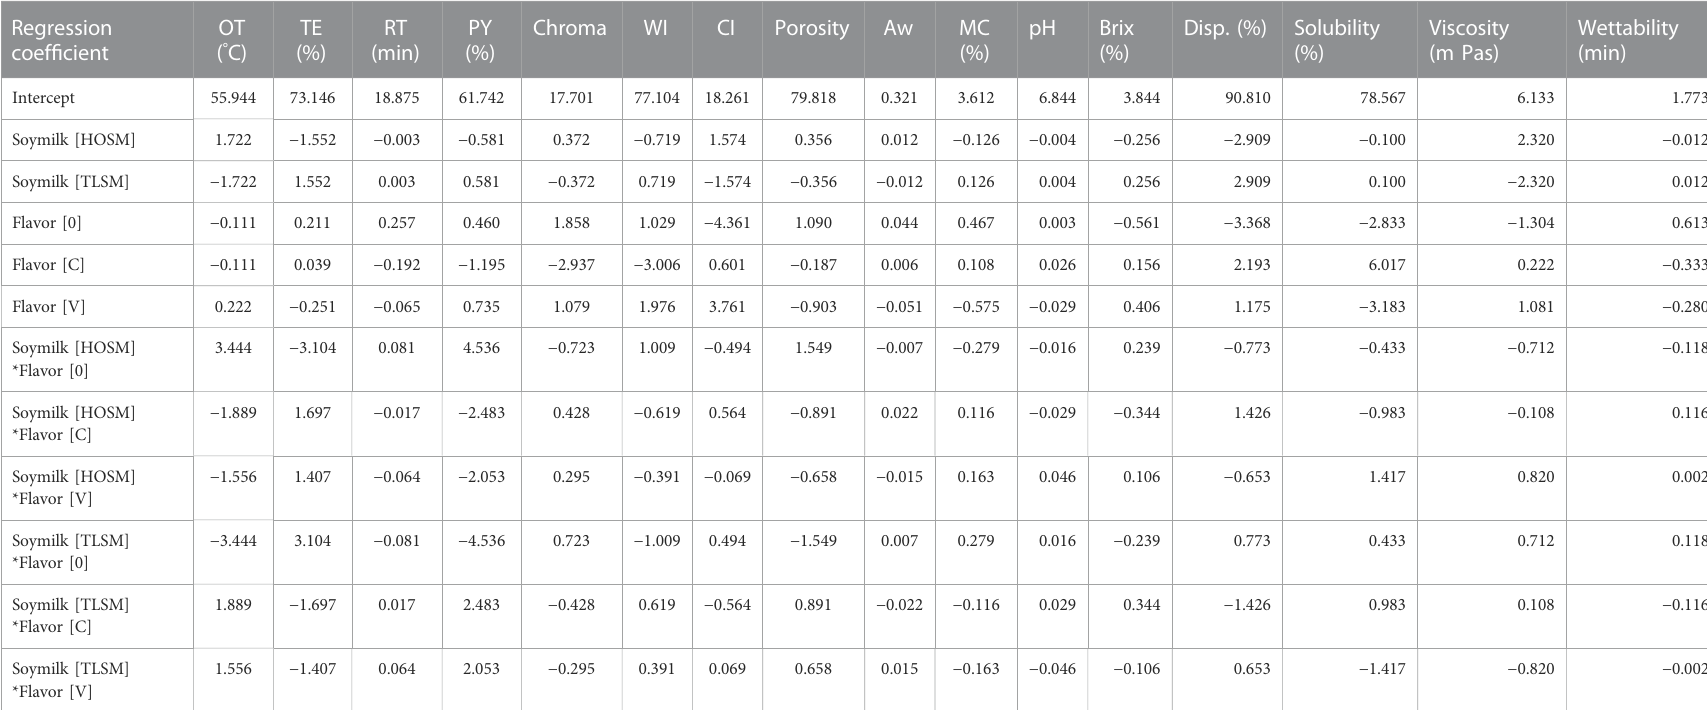
Regression coef fi